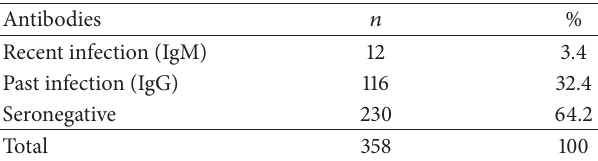
Table 1: Seroprevalence